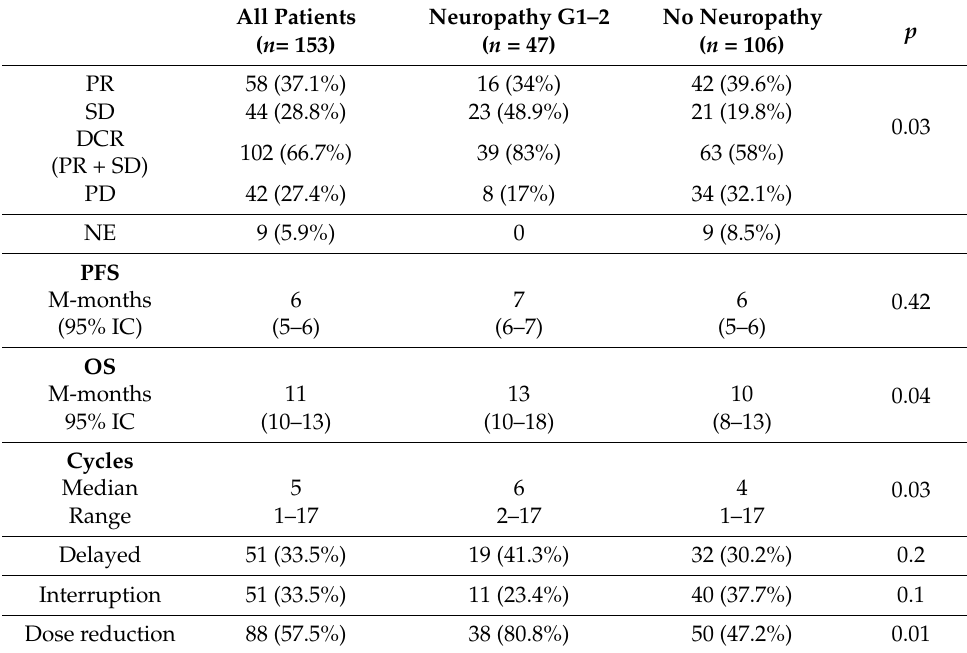
Table 2. Best response, PFS, and OS according to neutropenia grade.